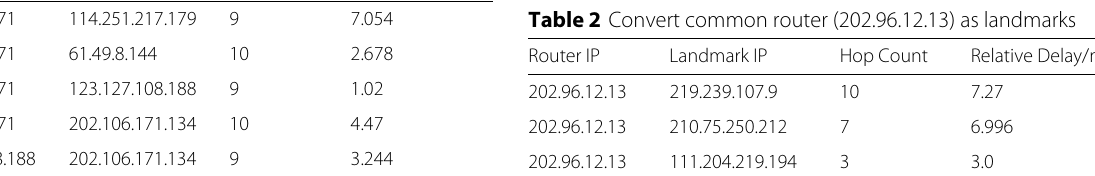
(CRG) and SLG, shown by solid curve and dashed curve respectively. As shown in Fig. 8, the largest geolocation error of the proposed algorithm is 18 km, but for SLG, the number is 37 km. The details are listed in Table 3. There are about 25% of geolocation results require common routers as landmarks. Especially, when using common routers as secondary landmarks, the results are signif-